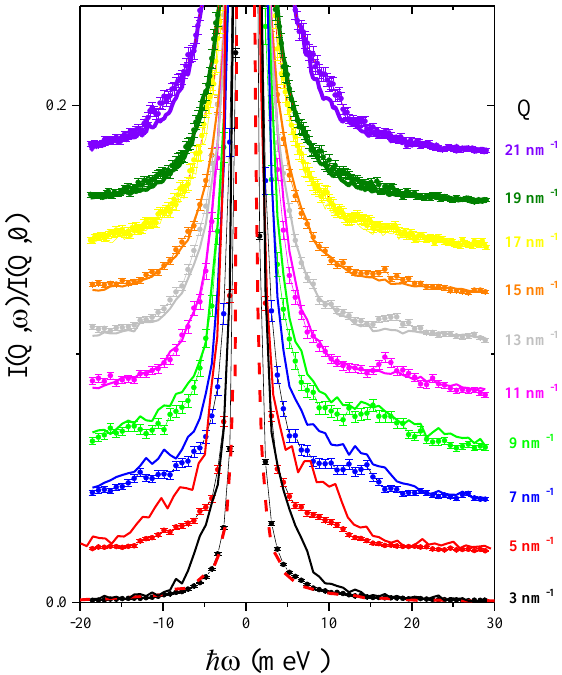
Figure 1. A cascade of spectra measured in the aqueous suspension 15 nm diameter Au-NPs (dots and error bars) and pure water (solid line) at the Q values specified in the plot. Data are normalized to the respective maxima and vertically offset by an amount proportional to Q . The lowest Q spectra are also compared with the energy resolution function after a similar normalization (red dashed